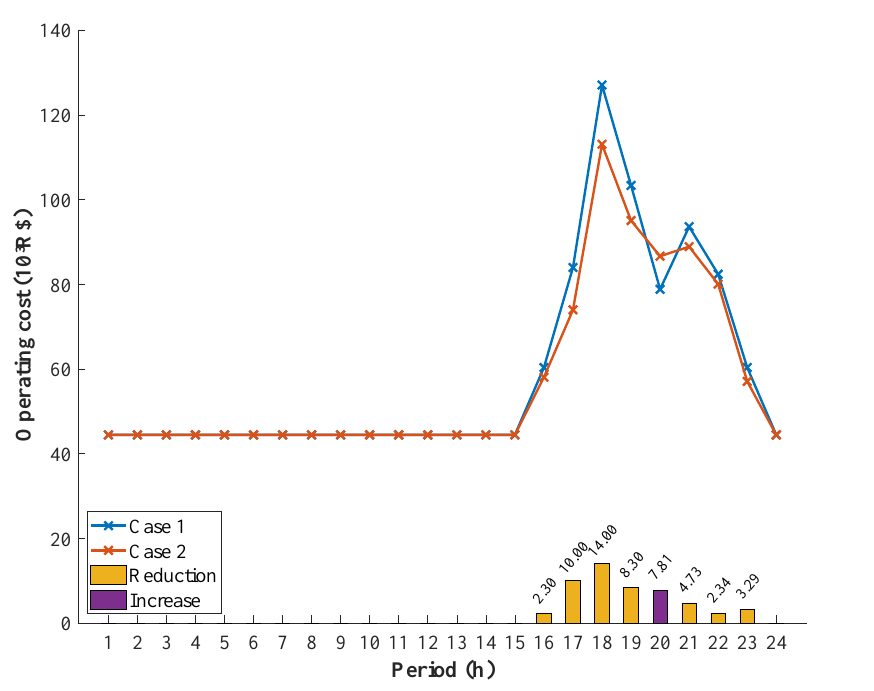
Figure 13. Operating costs in Case 1 and Case 2.